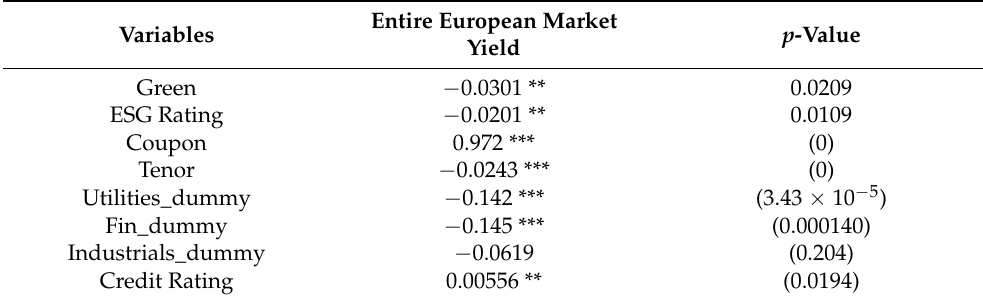
Table 5. The result of model (1) estimation with dummies on countries for the entire European